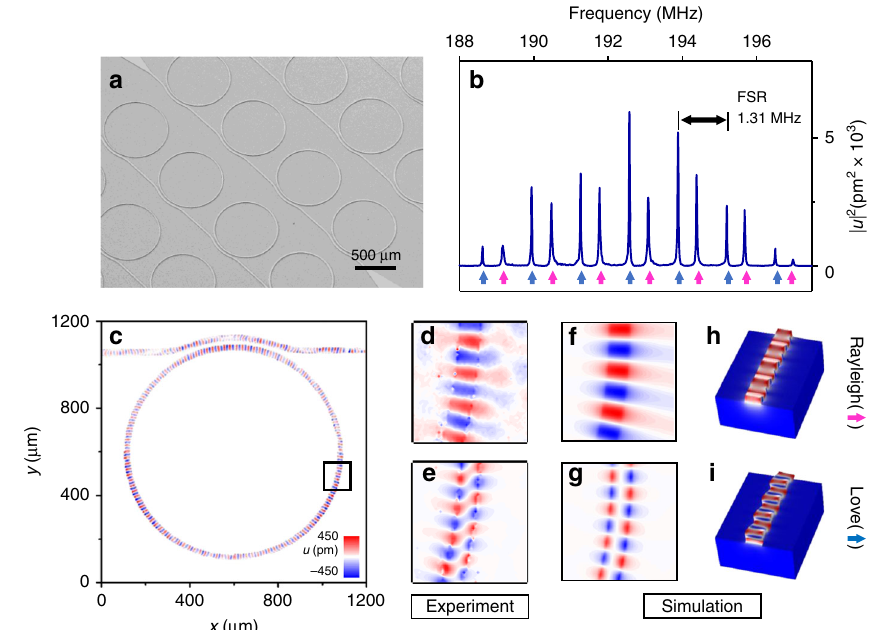
Fig. 3 Phononic ring resonator and mode identi fi cation. a An SEM image of arrays of phononic ring resonators. b A typical spectrum of the phononic ring resonator measured by the vibrometer with the focal point adjusted to the ring. Two sets of modes are observed, corresponding to Rayleigh-like and Love- like mode, marked with magenta and blue arrows, respectively. c The vibrometer image of a Rayleigh-like mode in a waveguide coupled ring resonator (only the displacement on the ring is presented). d , e The vibrometer images of the Rayleigh-like and Love-like modes. f , g Simulated z -direction displacement pro fi le of Rayleigh-like and Love-like modes, in excellent agreement with the experimental results. h , i Simulated 3-d mode pro fi les of Rayleigh-like and Love-like mode,